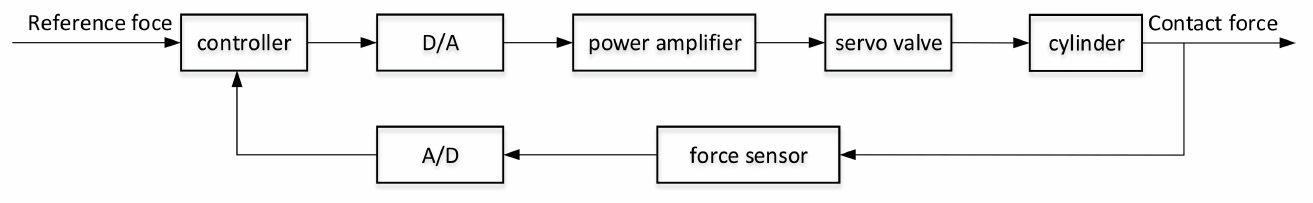
Figure 3. Block diagram of the pneumatic control system of the robot grinding and polishing